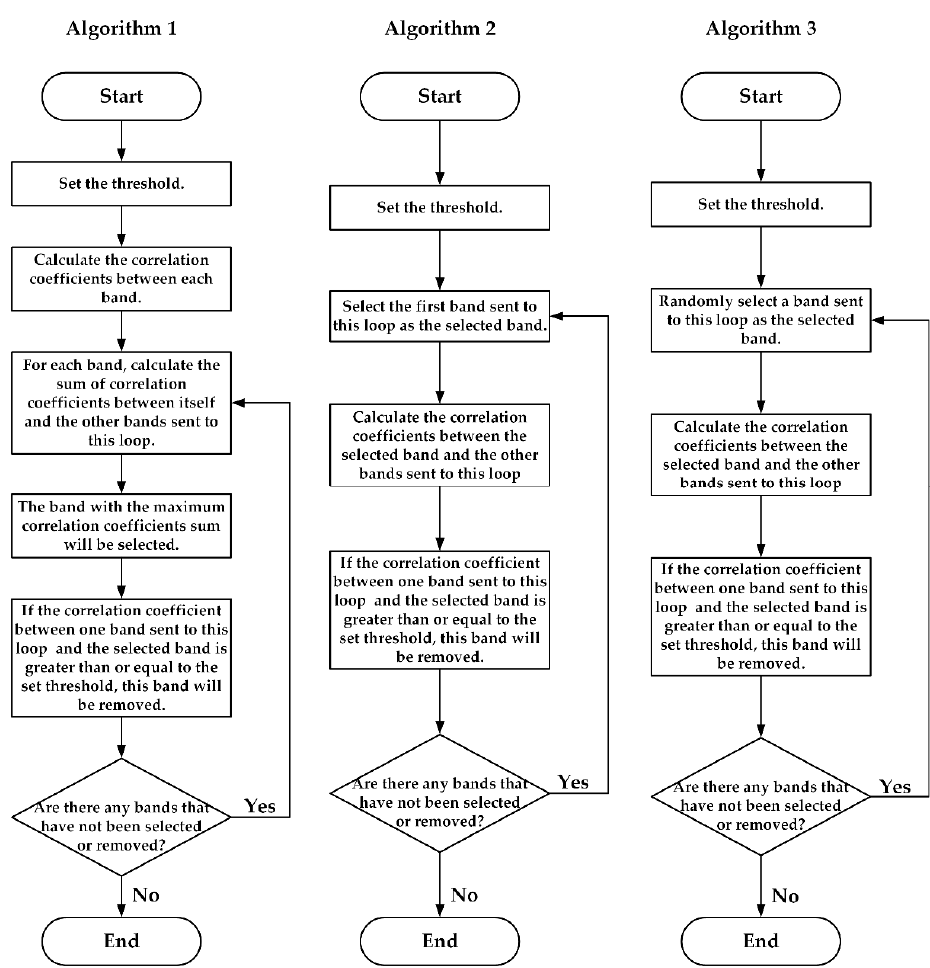
Figure 1. The workflow charts of the three compression algorithms based on data selection. In Algorithm 1, all the correlation coefficients between each band are calculated first.